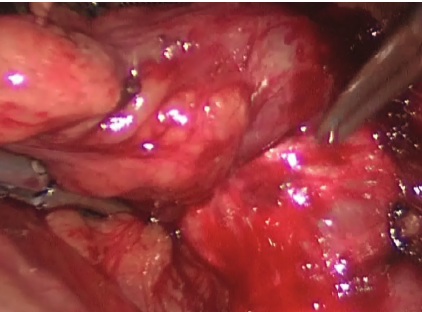
Figure 2: Resection of the cholecystocolic fistula by the help of the vascular Tri-Staple is seen (Covidien Endo GIA Reinforced Reload with Tri-Staple Technology).